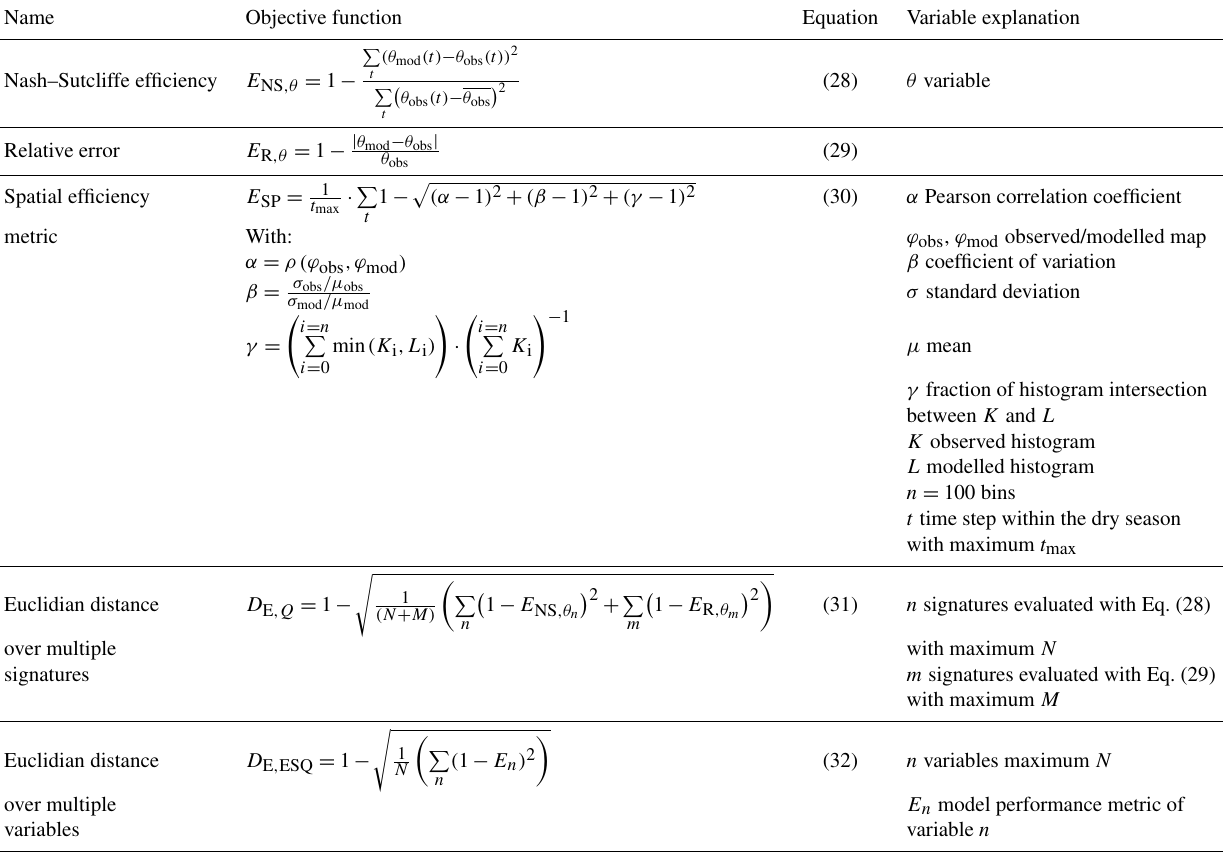
Table 4. Overview of equations used to calculate model